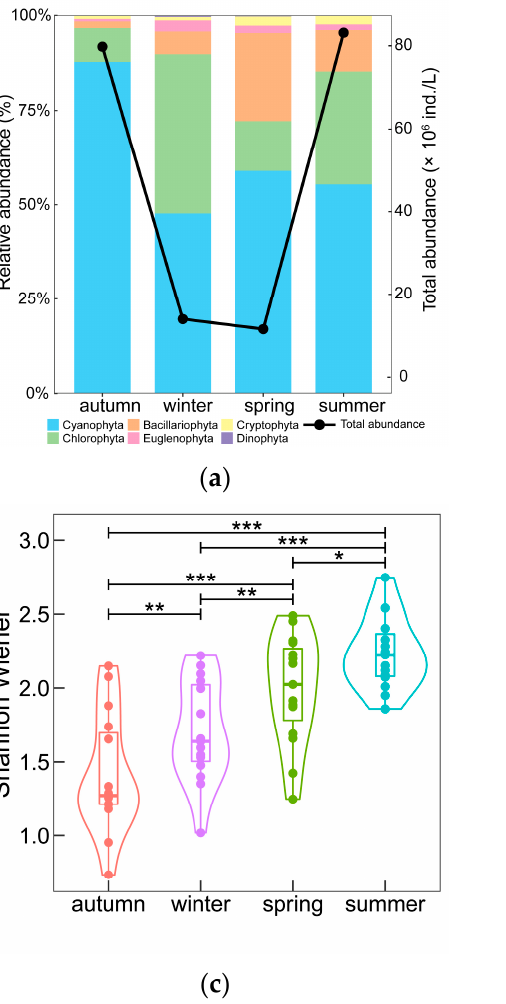
Figure 2. Seasonal variations of phytoplankton abundance and comparisons of the number of species, Shannon–Wiener index, and Pielou’s evenness among different seasons. ( a ) Relative abundance and total abundance of phytoplankton, where the bar stack diagram indicates relative abundance and point and line indicate total abundance; ( b ) Comparison of the number of species; ( c ) Comparison of Shannon–Wiener index; ( d ) Comparison of Pielou’s evenness. “***” denotes p < 0.01, while “**”denotes p < 0.05 and “*” p < 0.1.